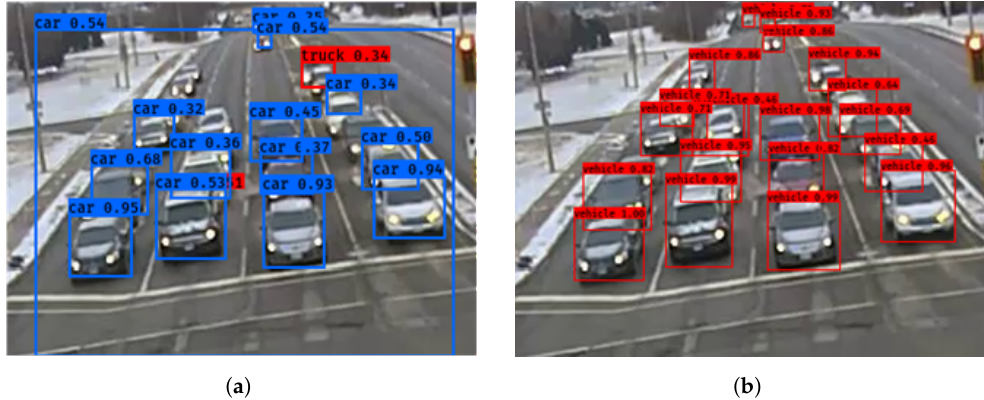
Figure 7. Inference with ( a ) original pre-trained COCO model (cars and trucks marked as blue and red colors respectively) and ( b ) improved model with transfer learning (vehicles marked as